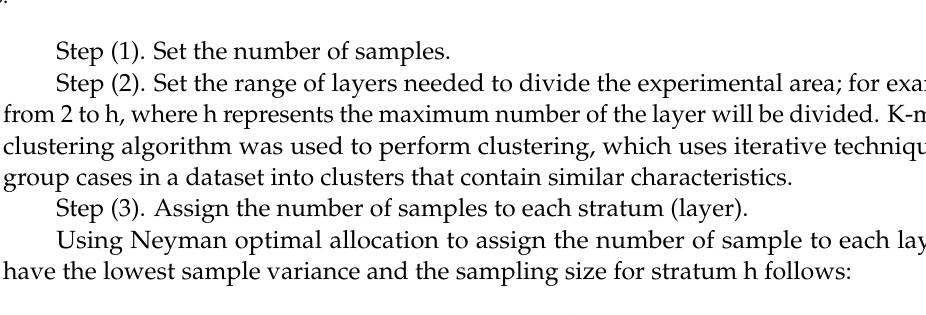
Figure 3. Flowchart of the approach; S (h, srs) represents the sample points determined by the SRS method when the sample area is divided into h